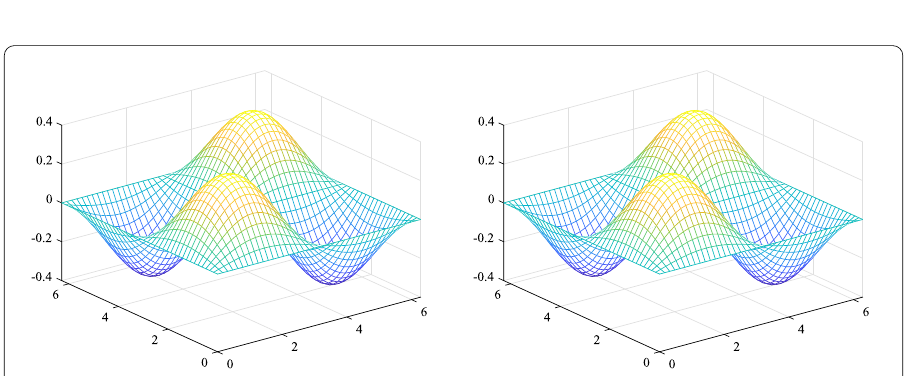
Figure 19 The numerical solution of CFDS6-SSM (left-hand side) and E-CFDS6-SSM (right-hand side) when J = 41, z = 0.4 π and t = 1 for SP 6